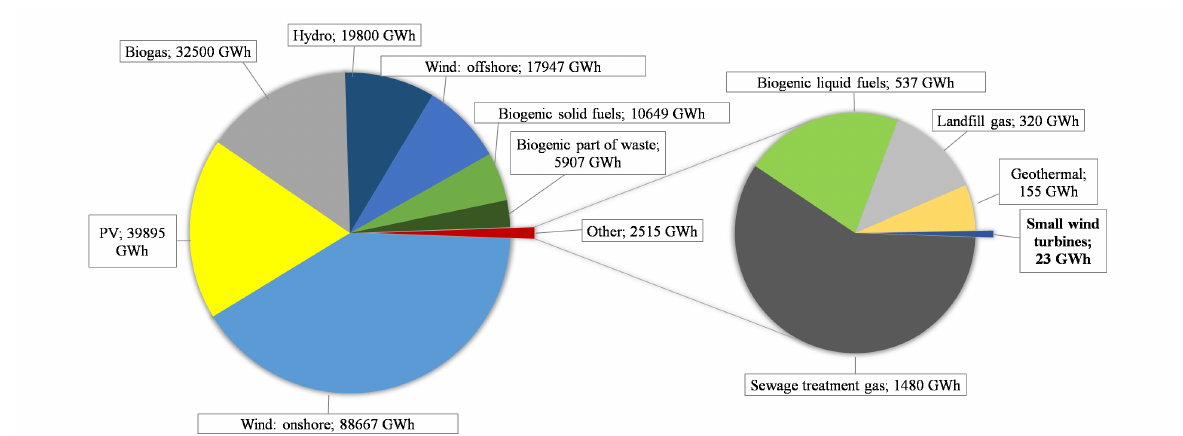
Figure 1. Share of produced electricity by type of plant in Germany 2017 according to (Gehling,